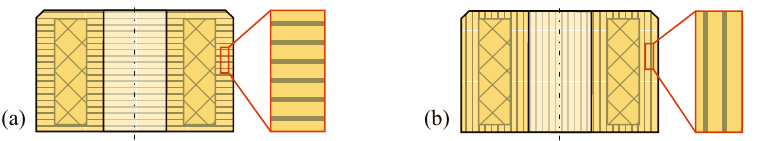
Figure 3. Schematic illustration of the orientation of the layer structure in the FLM test specimen: ( a ) layer orientation in the x – y plane and ( b ) layer orientation in the x – z plane.